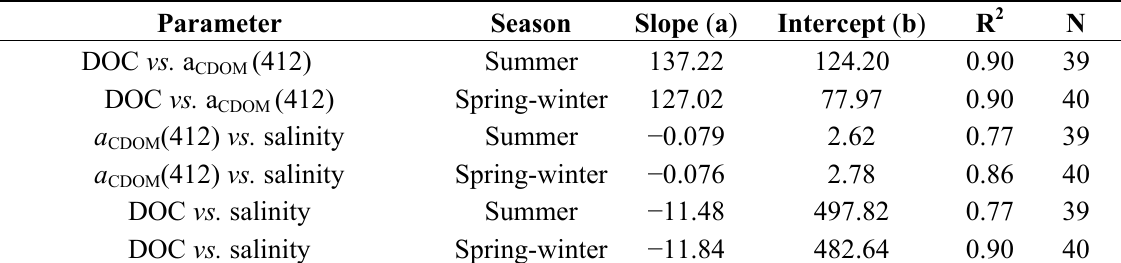
Table 3. Coefficients resulting from regression analysis between a and